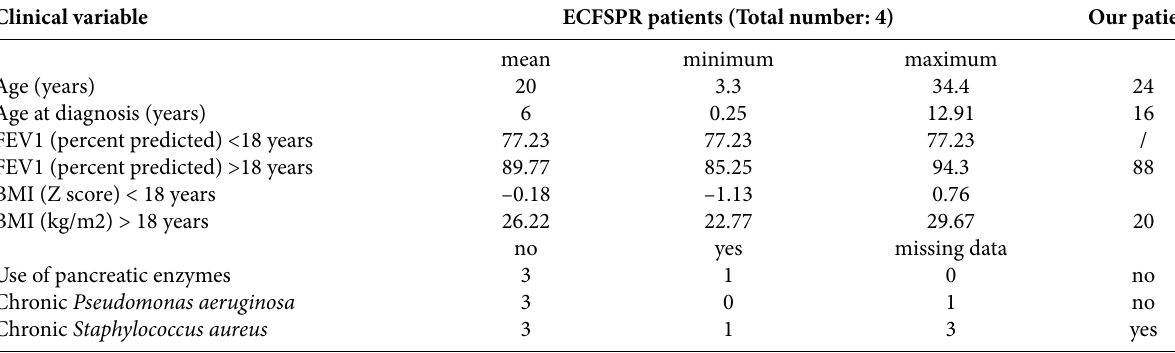
Table 2. Comparison of clinical data of patients with the c.3140-26A>G CFTR variant in homozygous state listed in the ECFSPR with the data of our patient. Clinical variable